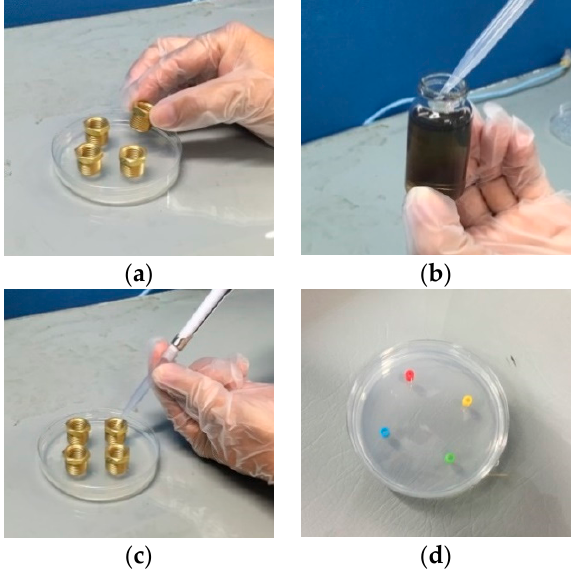
Figure 4. Pictures of inhibition zone test process: ( a ) metal rings placed on culture medium; ( b ) pipette extracts 0.15 mL test solution; ( c ) NO.1~NO.4 test solutions injected into metal rings, respectively; ( d ) metal rings carefully removed 30 min later and signs placed. Table 1. Experimental design and configuration.